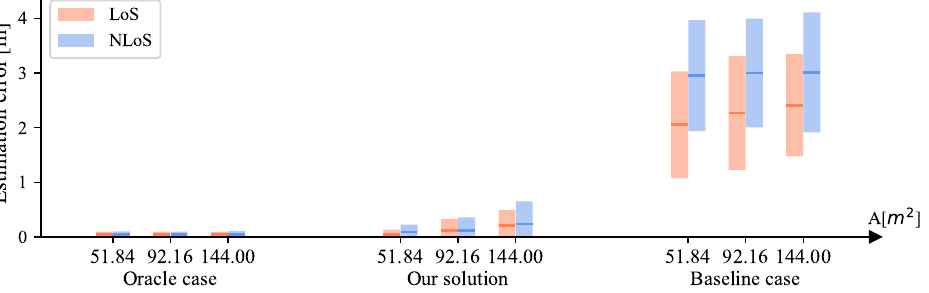
Figure 18. The location-estimation errors of both LoS and NLoS areas for the oracle/baseline cases C = 144, A = 51.84/92.16/144.00, σ = 0 and our solution when { e , for each bar, the middle line is mean ( e ) , i.e., MSE, and its height ranges from MSE MSE + std ( e )